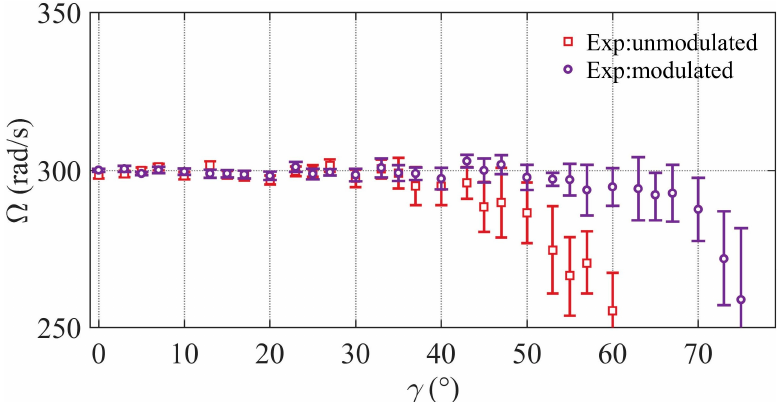
Figure 7. Experimentally measured rotating velocity as a function of the tilt angles with the unmodulated and modulated OAM light fields. The disk spun with a constant angular speed of 300 rad/s.